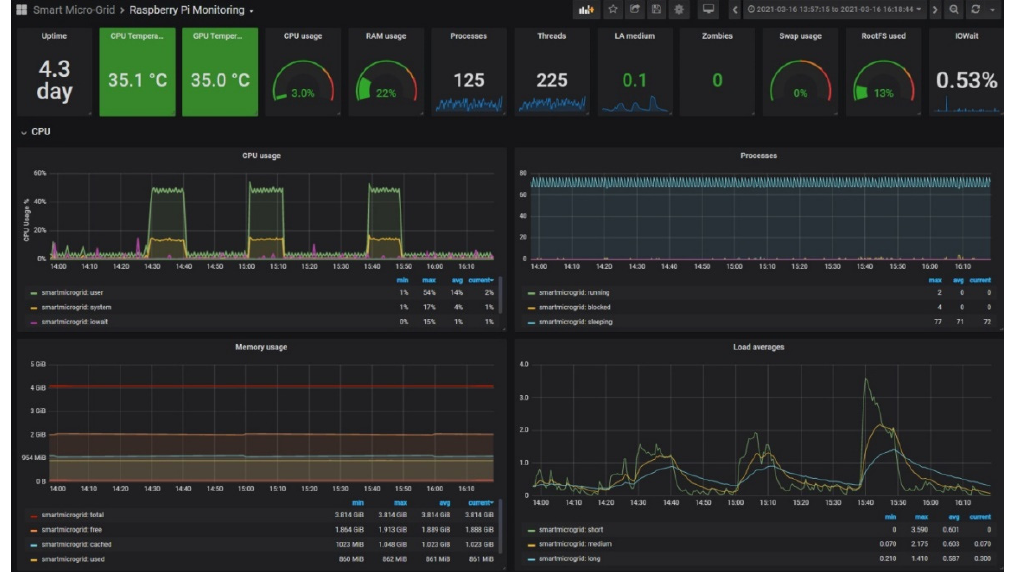
Figure 13. Dashboard devoted to monitoring the resources of RPi during experiments.